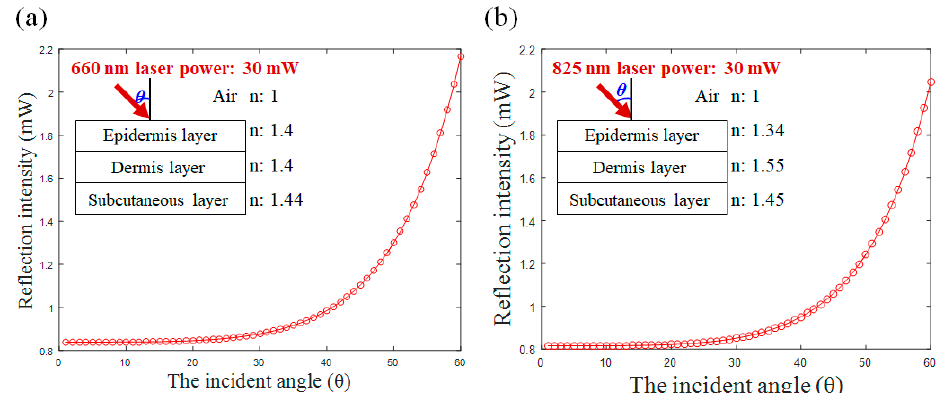
Figure 3. The simulation of ( a ) 660 nm and ( b ) 825 nm lasers irradiated on skin with different incident angles. Here, n is the refractive index.